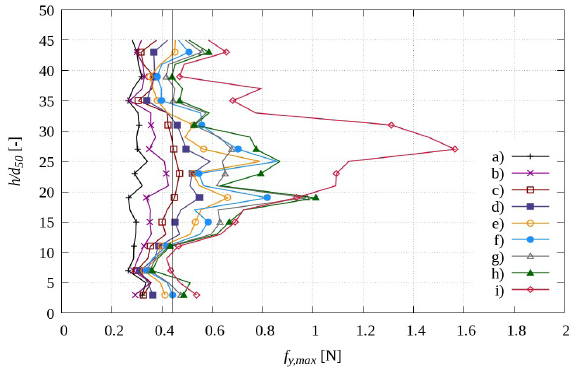
acting on spheres y at the specimen 50 = 0.25 mm, b) u = 0.50 mm, c) u = 0.75 mm, d) x x x = 1.25 mm, f) u = 1.50 mm, g) u = 1.75 mm, h) x x x = 10.00 mm ( e = 0.60, σ = 200 kPa, x 0 0